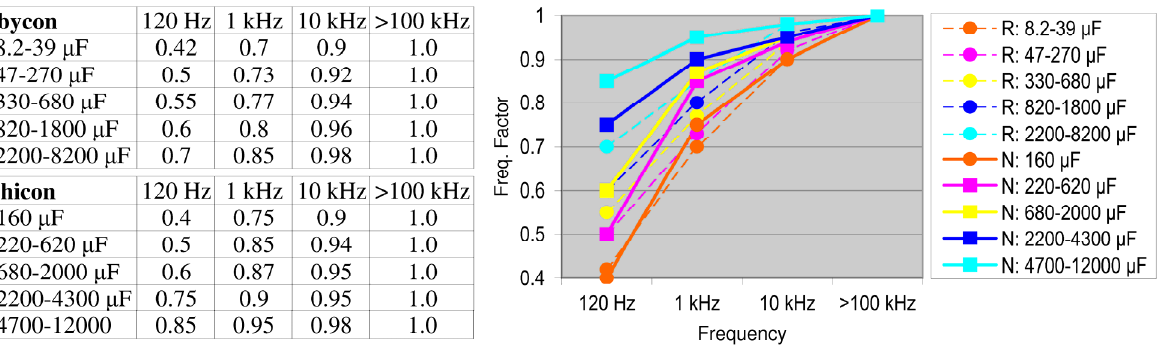
Figure 1. Frequency factors for aluminum electrolytic capacitors as reported by manufacturers [87,88].